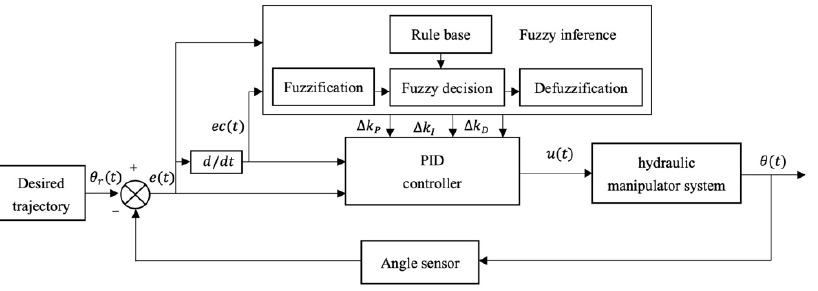
Figure 7. Structure of fuzzy PID controller.